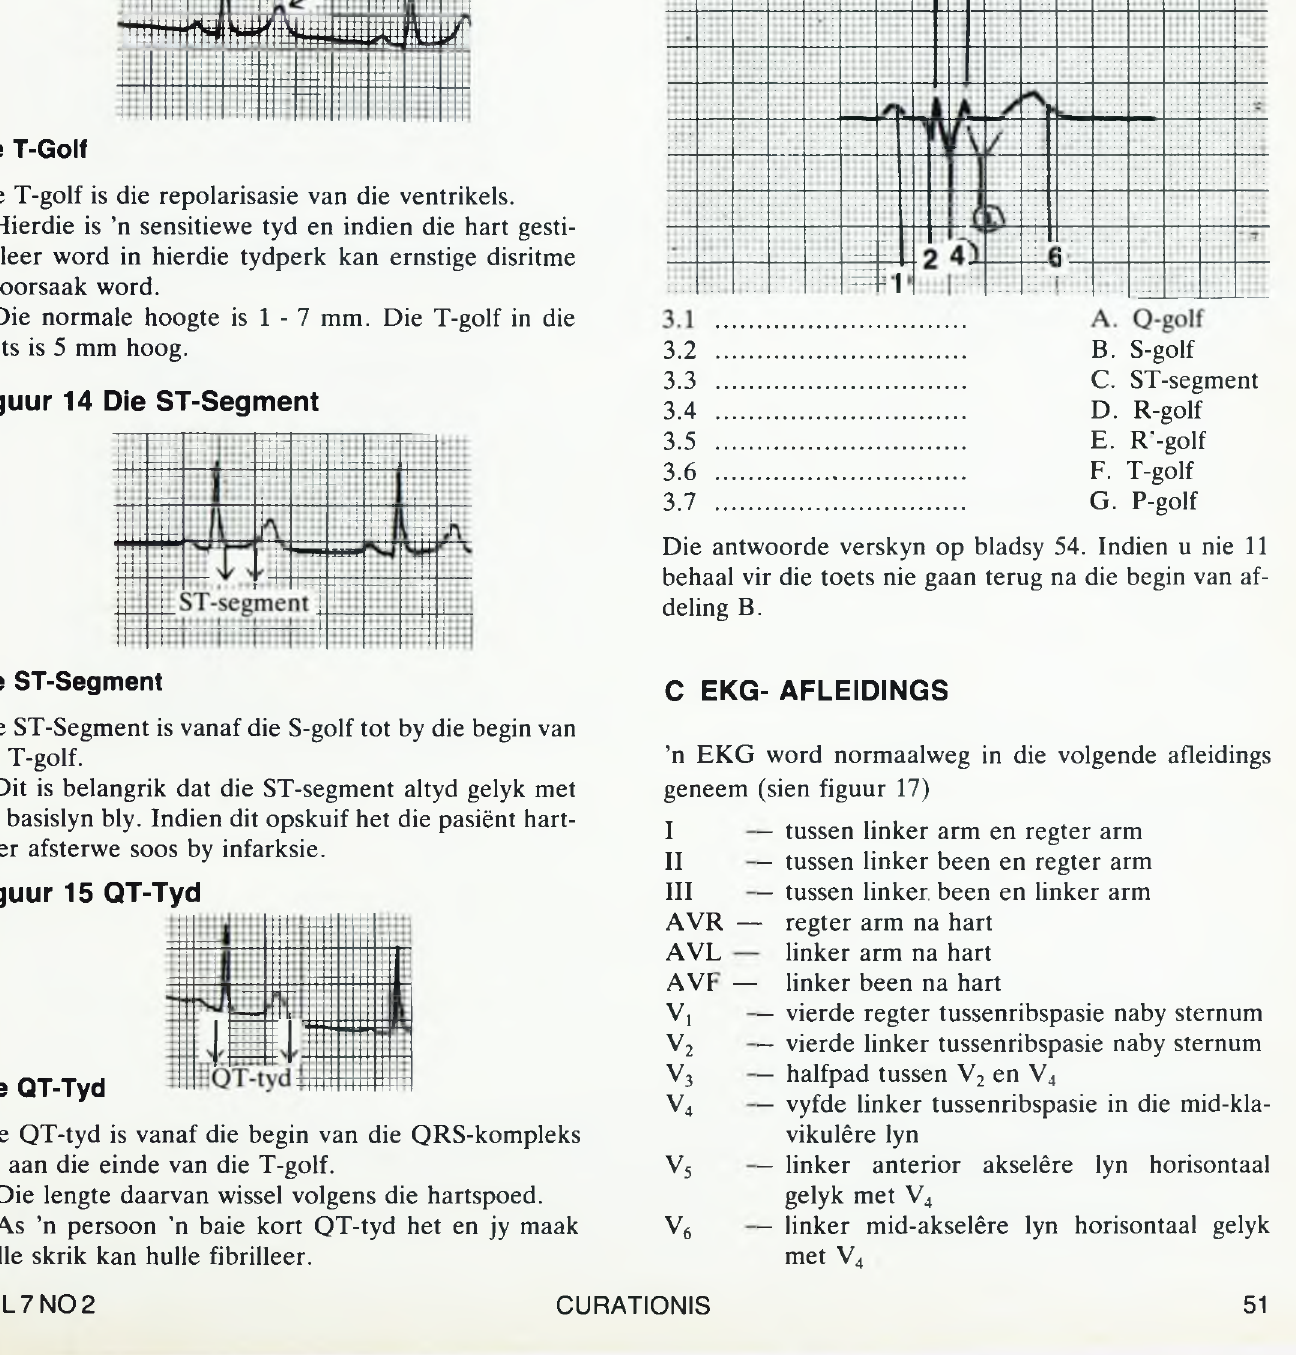
aSSjgSBggffilBI